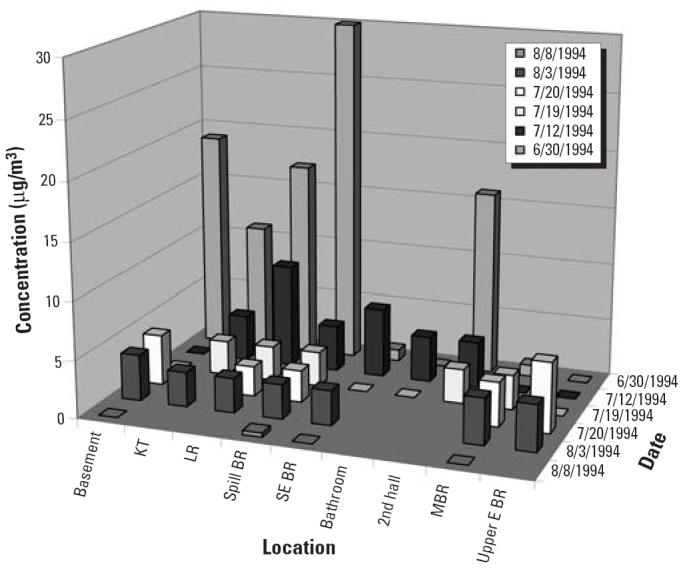
Airborne Hg0 concentrations after children broke a medical device with one pound of mercury. Abbreviations: BR, bedroom; E, eastern; KT, kitchen; LR, living room; MBR, master bedroom; SE, southeastern.